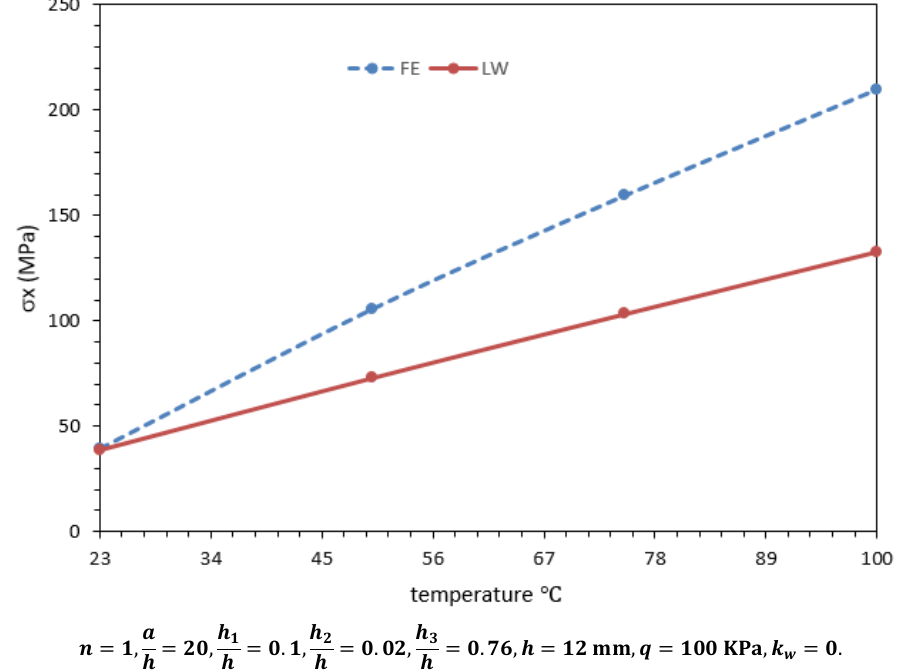
Figure 5. Effect of the thermal loads on the maximum normal stresses of sandwich plate (for point 6).